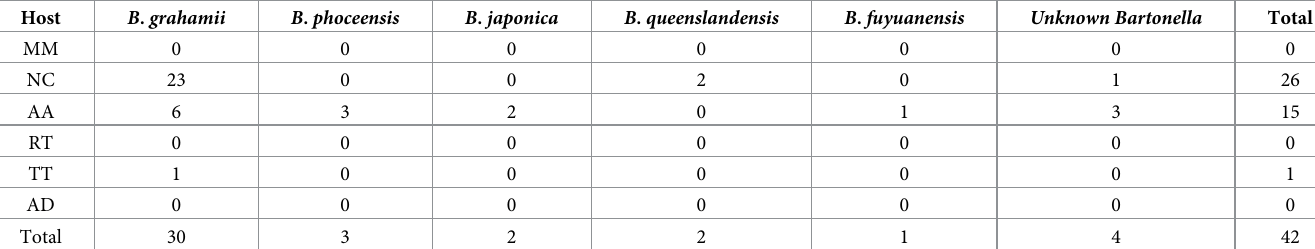
Table 3. Distribution of Bartonella species in the infected small rodents.